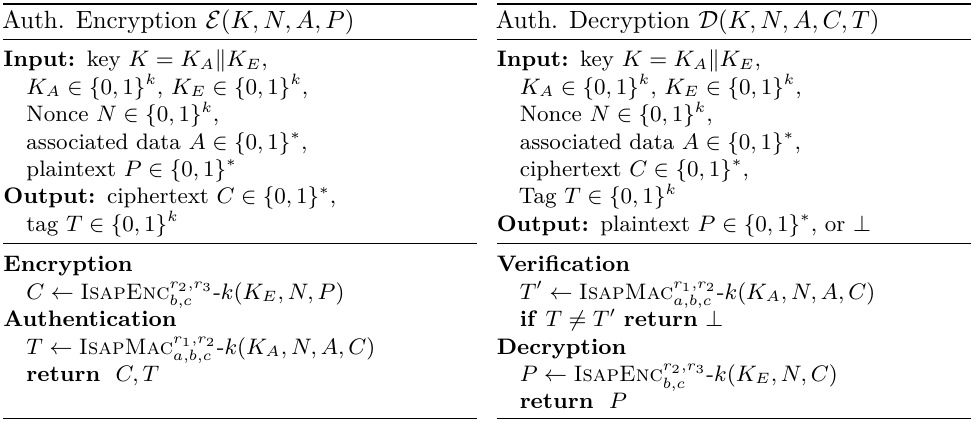
Algorithm 1: Authenticated encryption and decryption